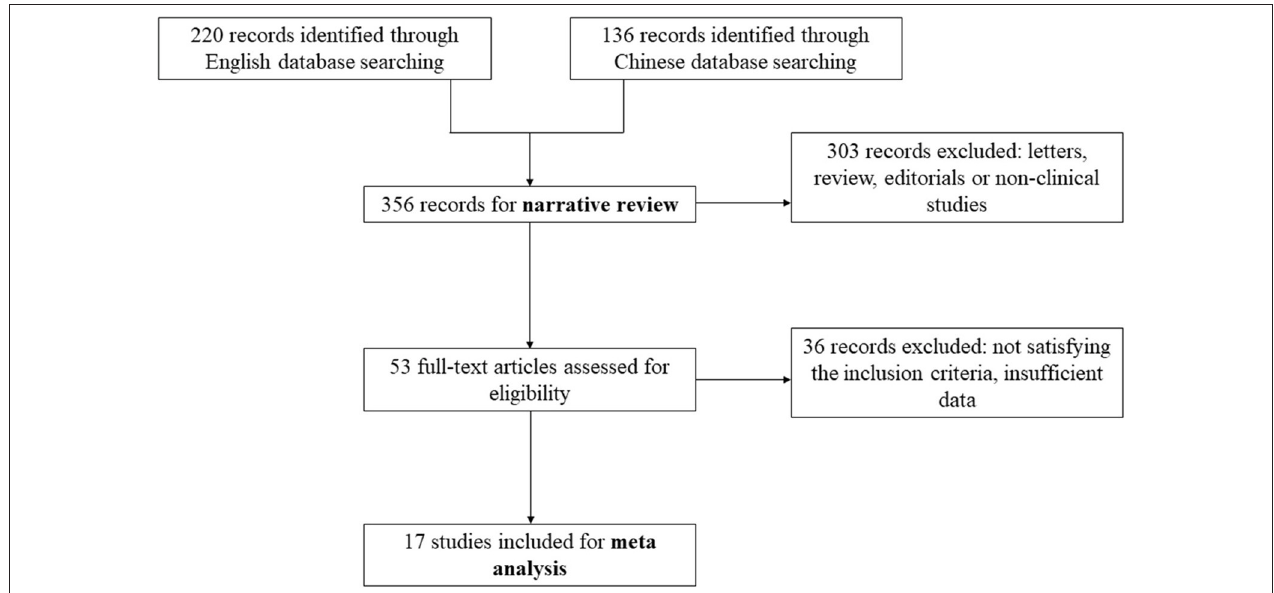
FIGURE 1 | Process of study